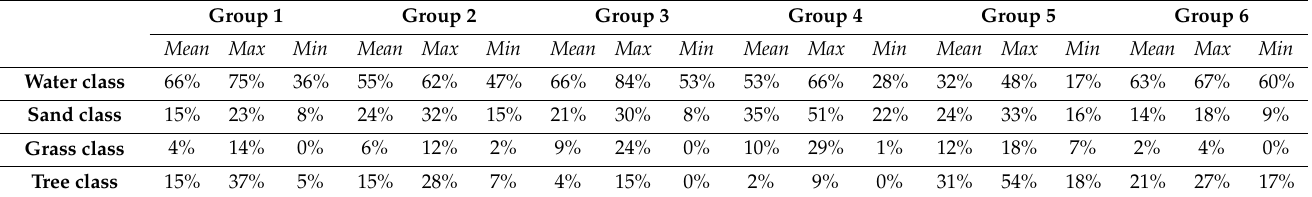
Table 2. Land cover characteristic in Groups 1–6 classified according to Ward’s method.